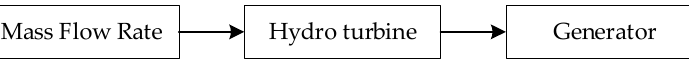
Figure 11. Basic operation model of run-of-river hydro generation.